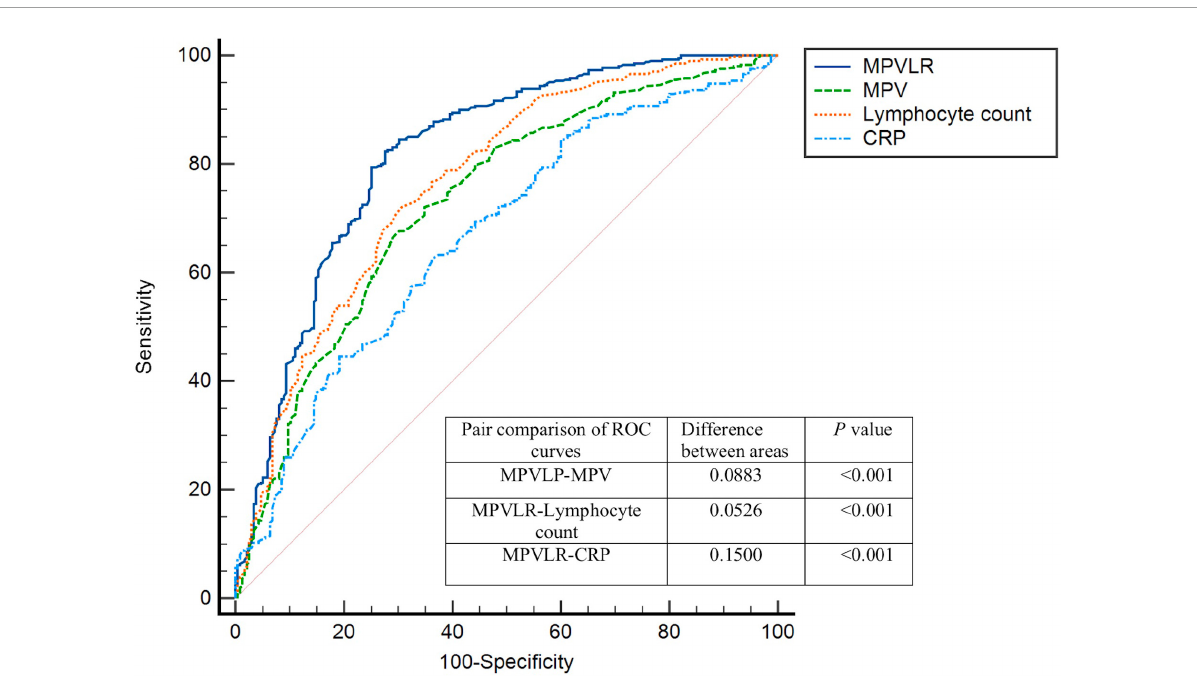
FIGURE1 Receiver-operating characteristics (ROC) curves for MPVLR, MPV, CRP, and lymphocyte count value in the prediction of impaired coronary collateral circulation. MPVLR, mean platelet volume to lymphocyte ratio; MPV, mean platelet volume; CRP, C-reactive